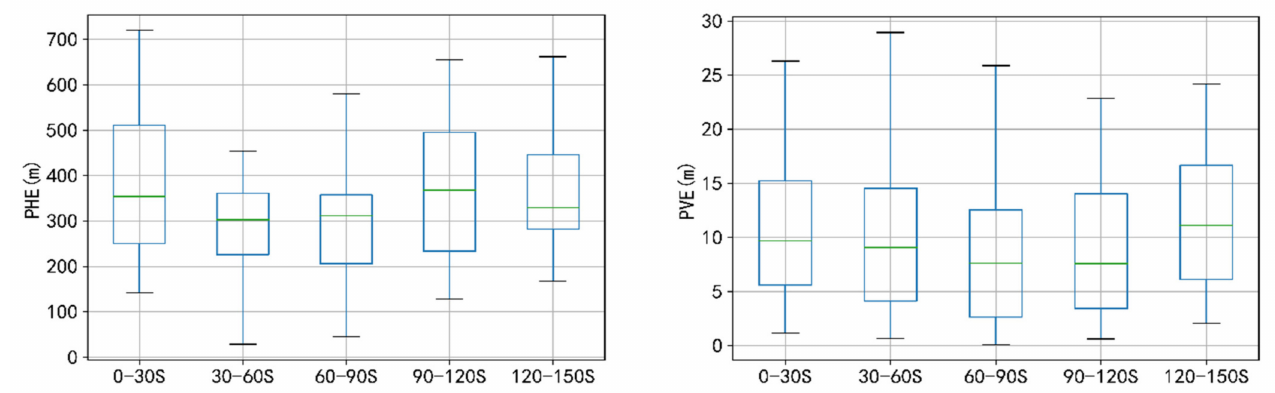
Figure 6. Box plots of different evaluation indicators for arrival